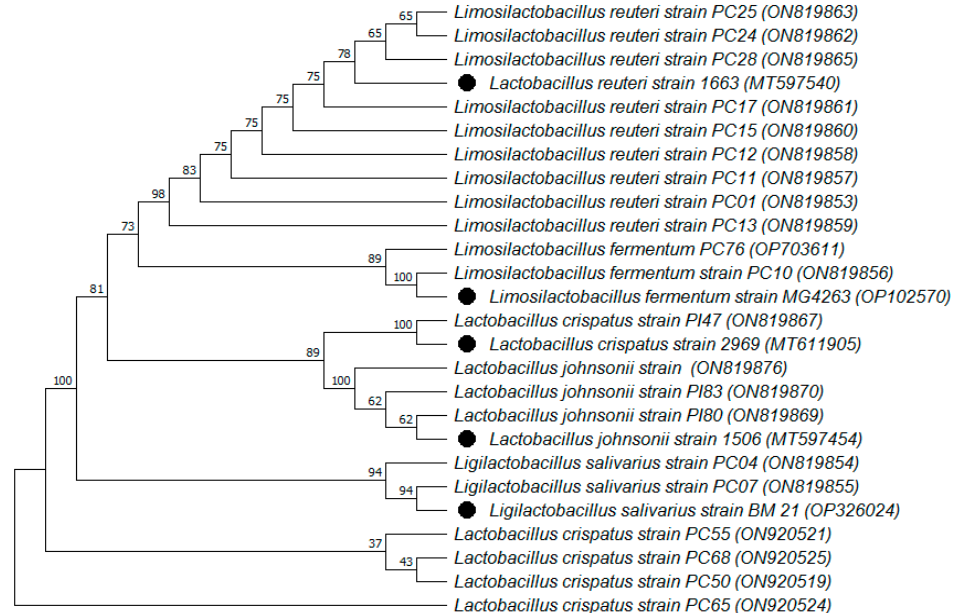
Figure 1. A phylogenetic tree was constructed by using the neighbor joining method. It shows the genetic resemblance of Lactobacillus species isolated in this study with reference strains based on their partial 16S rRNA gene sequence. Reference strains represented with filled circles were taken from the NCBI database. Branches indicate the bootstrap percentage after 1000 replications. Codes in parenthesis are GenBank accession numbers of the isolates.